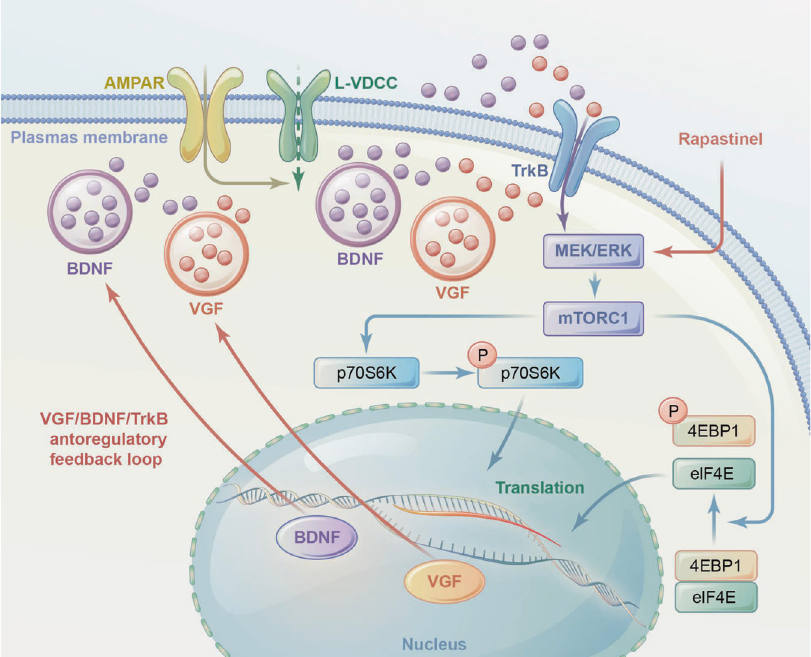
Fig. 5 The working model of the antidepressant-like actions of single or repeated treatment with rapastinel in mice. Our results showed ERK-mediated mTOR signaling may play critical in the antidepressant-like effects of repeated treatment with rapastinel in mice. Our data further indicated that these effects may be mediated partly through the ability of rapastinel to enhance VGF and BDNF expression and then the VGF/BDNF/TrkB autoregulatory feedback loop by increasing the ERK/mTOR pathway. The VGF/BDNF/TrkB autoregulatory feedback